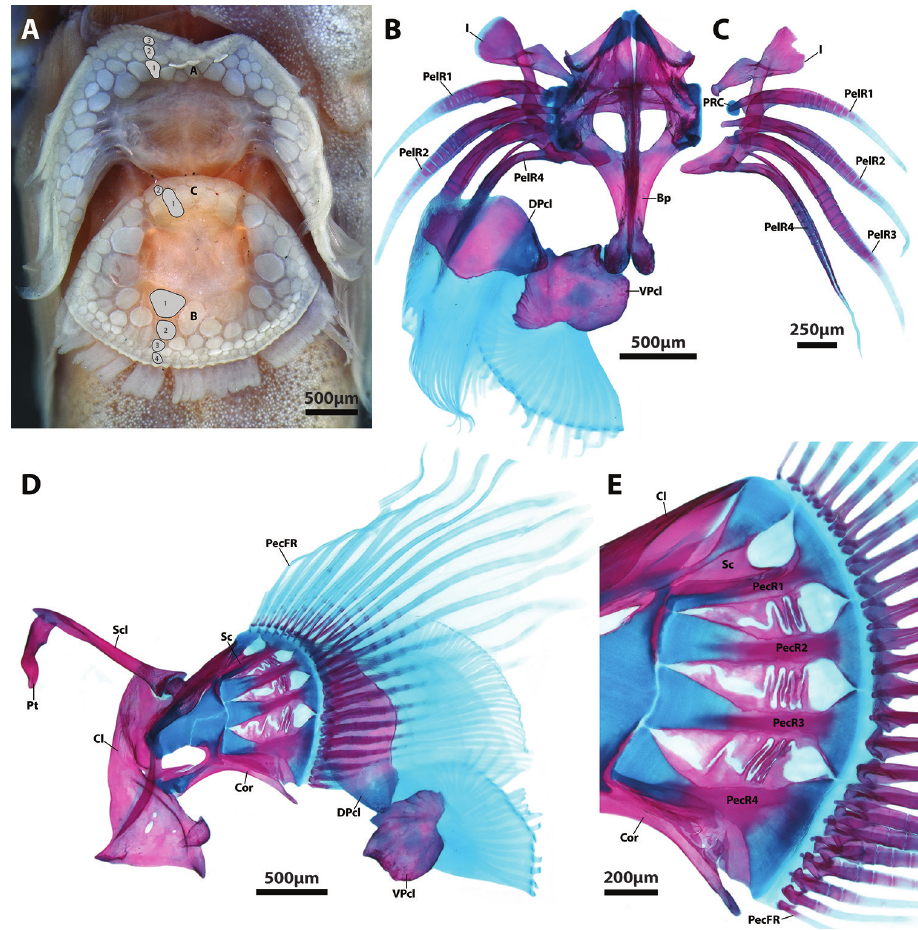
Figure 9. Surface features of the adhesive disc ( A NMNZ P.025315, paratype, 19.4 mm SL) and internal supporting skeleton of the paired-fin girdles ( B–E AIM MA655142, paratype, 20.0 mm SL) of Flexor incus . A Adhesive disc in ventral view (anterior to top of page); a single row of papillae highlighted in grey in each region (A–C) of the adhesive disc B Adhesive disc supporting skeleton, including elements of the pelvic and pectoral-fin girdle in dorsal view (anterior to top of page); postcleithra and pelvic-fin rays of the right side removed C Pelvic-fin rays of right side in dorsal view (anterior to top of page) D Pectoral-fin girdle of right side in medial view (anterior to left) E Close-up of elements of the pectoral-fin endoskeleton articulating with pectoral-fin rays of the right side in medial view (anterior to left). Abbreviations: A, disc region A; B, disc region B; Bp, basipterygium; C, disc region C; DPcL, dorsal postcleithrum; I, pelvic-fin spine; PecR1– 4, pectoral radial 1–4; PecFR, pectoral-fin ray; PelR1–4, pelvic-fin rays 1–4 VPcL, ventral